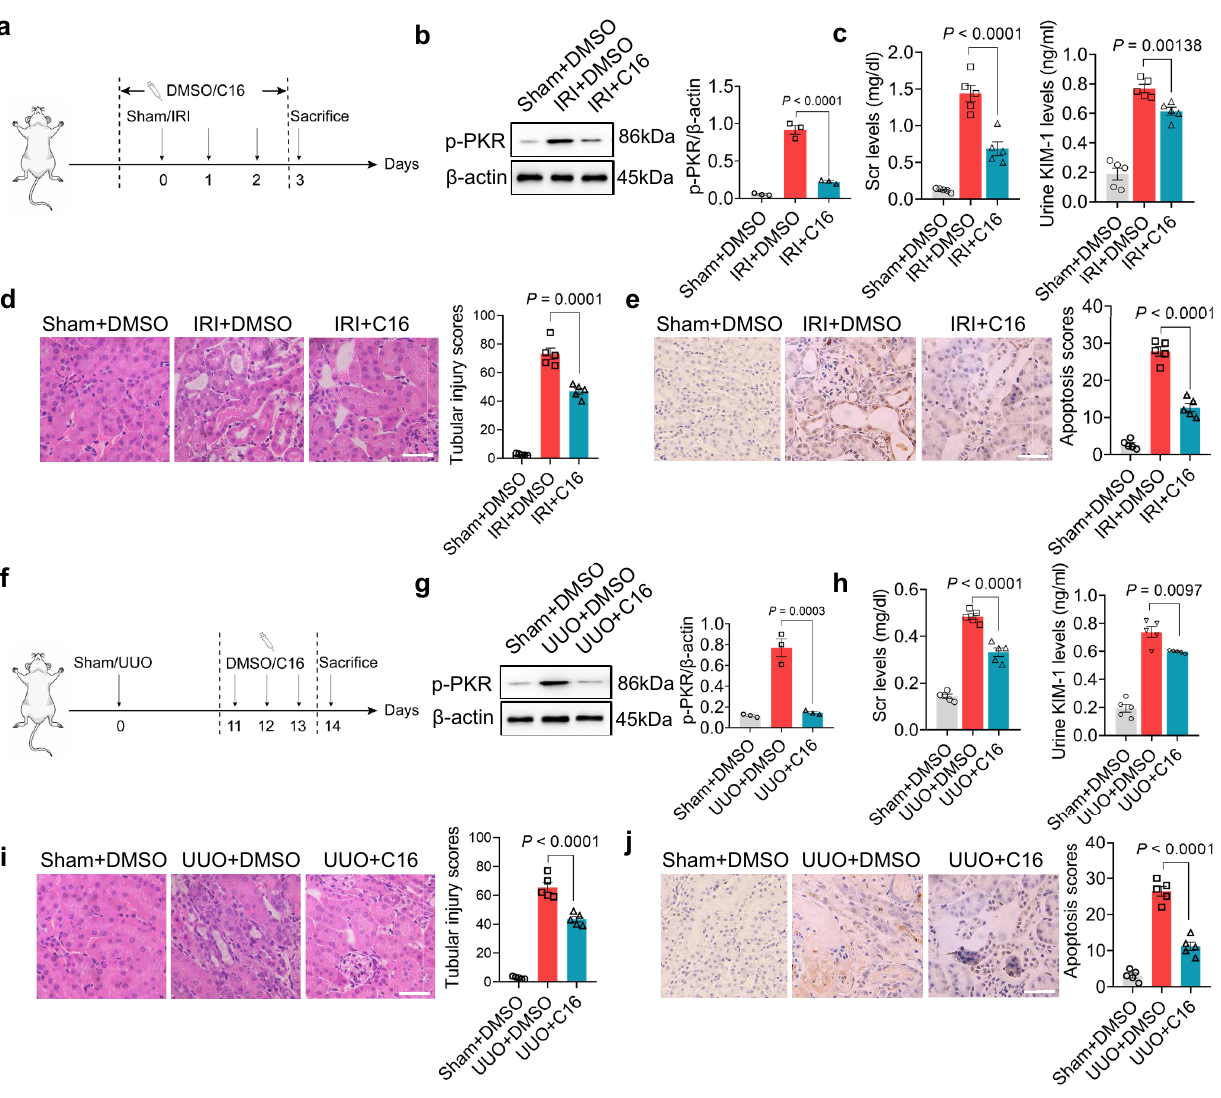
Fig.6|InhibitionofPKRprotectedrenaltubuleagainstinjuryinexperimental mousemodels.a Schematicof experimentalapproachinIRImousemodelwithor withoutC16treatment. b Left:WBof renaltubularp-PKRlevelsinIRImousemodel with or without C16 treatment. Right: quanti fi cation of renal tubular p-PKR levels (3mice/group). c Left:ScrinIRImousemodelwithorwithoutC16treatment.Right: urinary KIM-1 levels in IRI mouse model with or without C16 treatment (5 mice/ group). d Left:H&EstainingofkidneytissuesectionsfromIRImousemodelwithor without C16 treatment. Right: quanti fi cation of kidney disease score (5 mice/ group). e Left:TUNELassayofkidneytissuesectionsfromIRImousemodelwithor withoutC16treatment.Right:quanti fi cationofapoptosisinkidneytissues(5mice/ group). f Schematic of experimental approach in UUO mice with or without C16 treatment. g Left: WB of renal tubular p-PKR levels in in UUO mice with or without